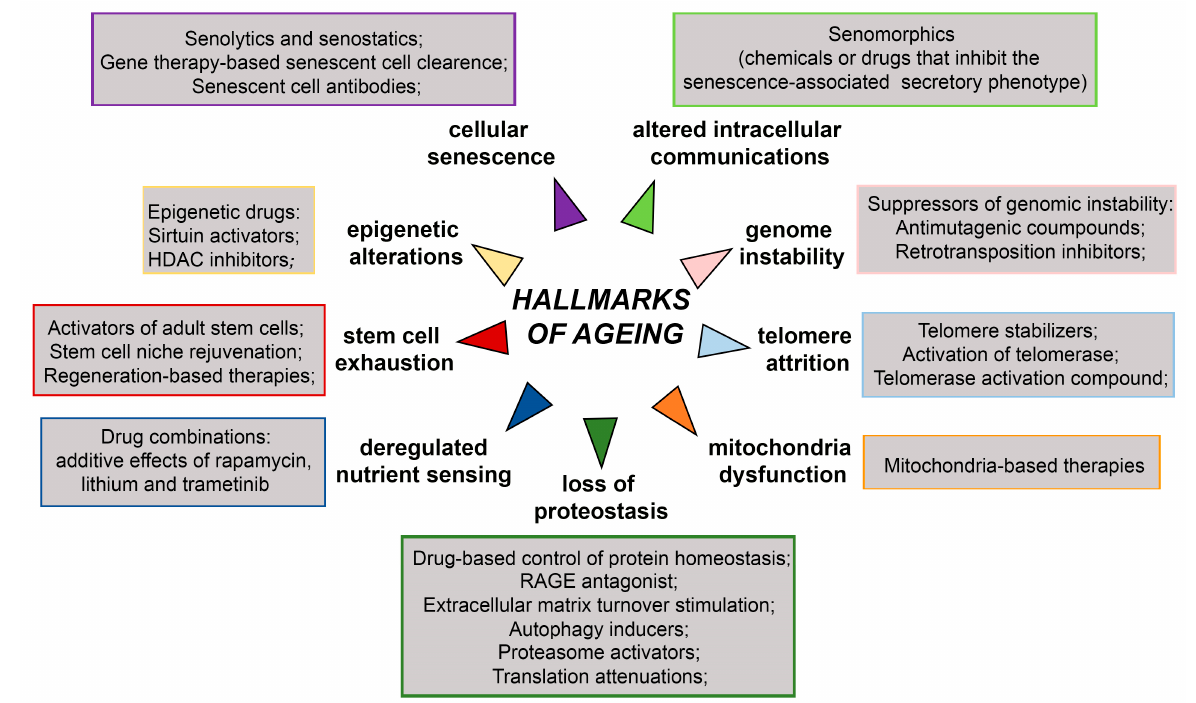
Figure 5. Schematic representation of anti-ageing therapies targeting hallmarks of ageing. HDAC—Hystone deacetilase, RAGE- receptor for advanced glycation end products. The scheme is based on the previously reported publications [7,171,172].